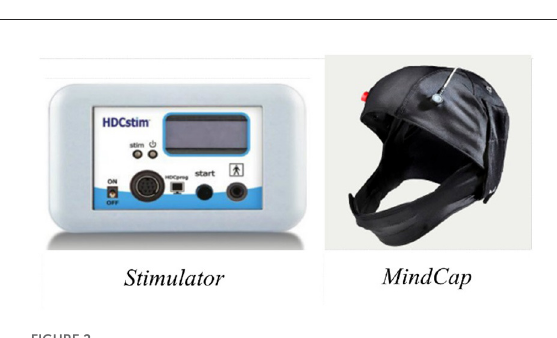
FIGURE2 Equipment for TDCS